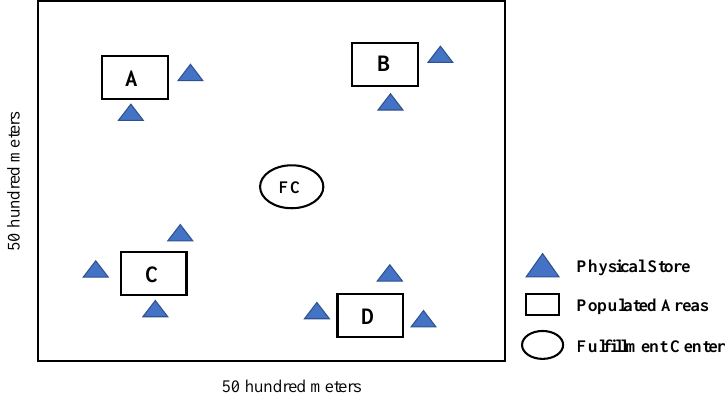
Figure 4. Setting of experimental scenarios.